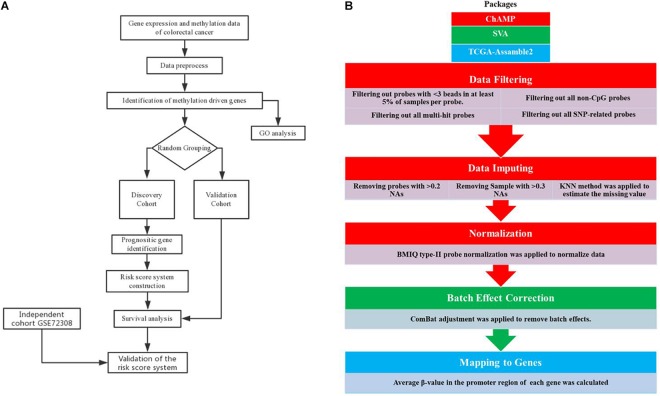
Analysis pipeline. Flowchart of the (A) prognosis-scoring model construction process and (B) data preprocess.